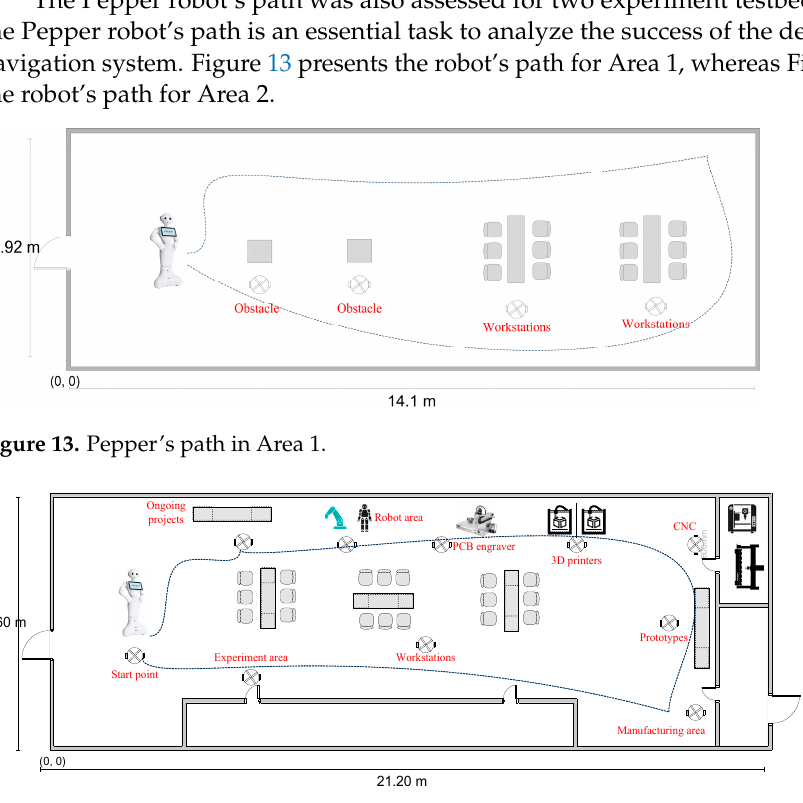
Figure 14. Pepper’s path in Area 2.